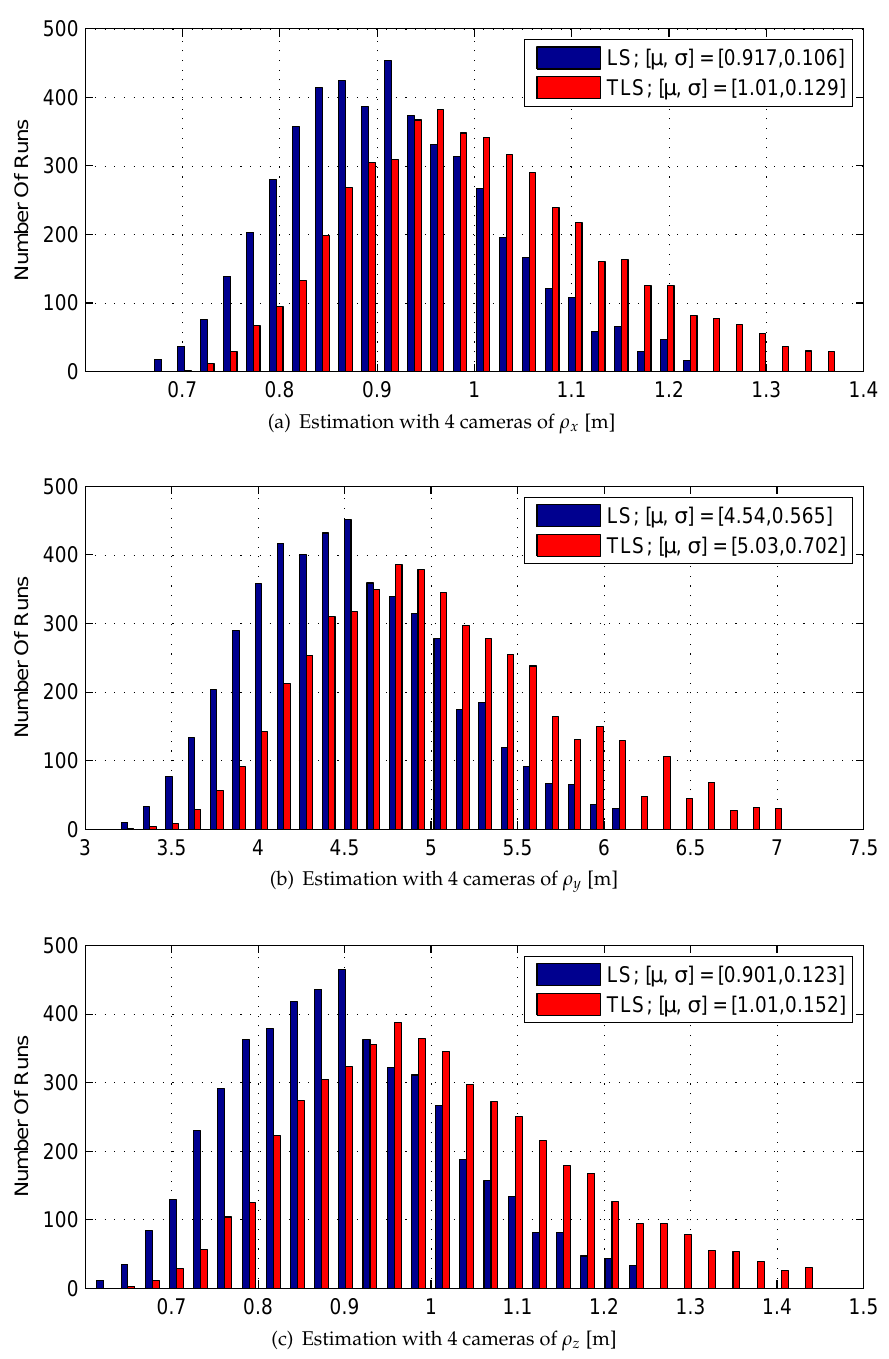
Figure 9. Monte carlo results of a static LOS estimation using stereovision measurements with 4